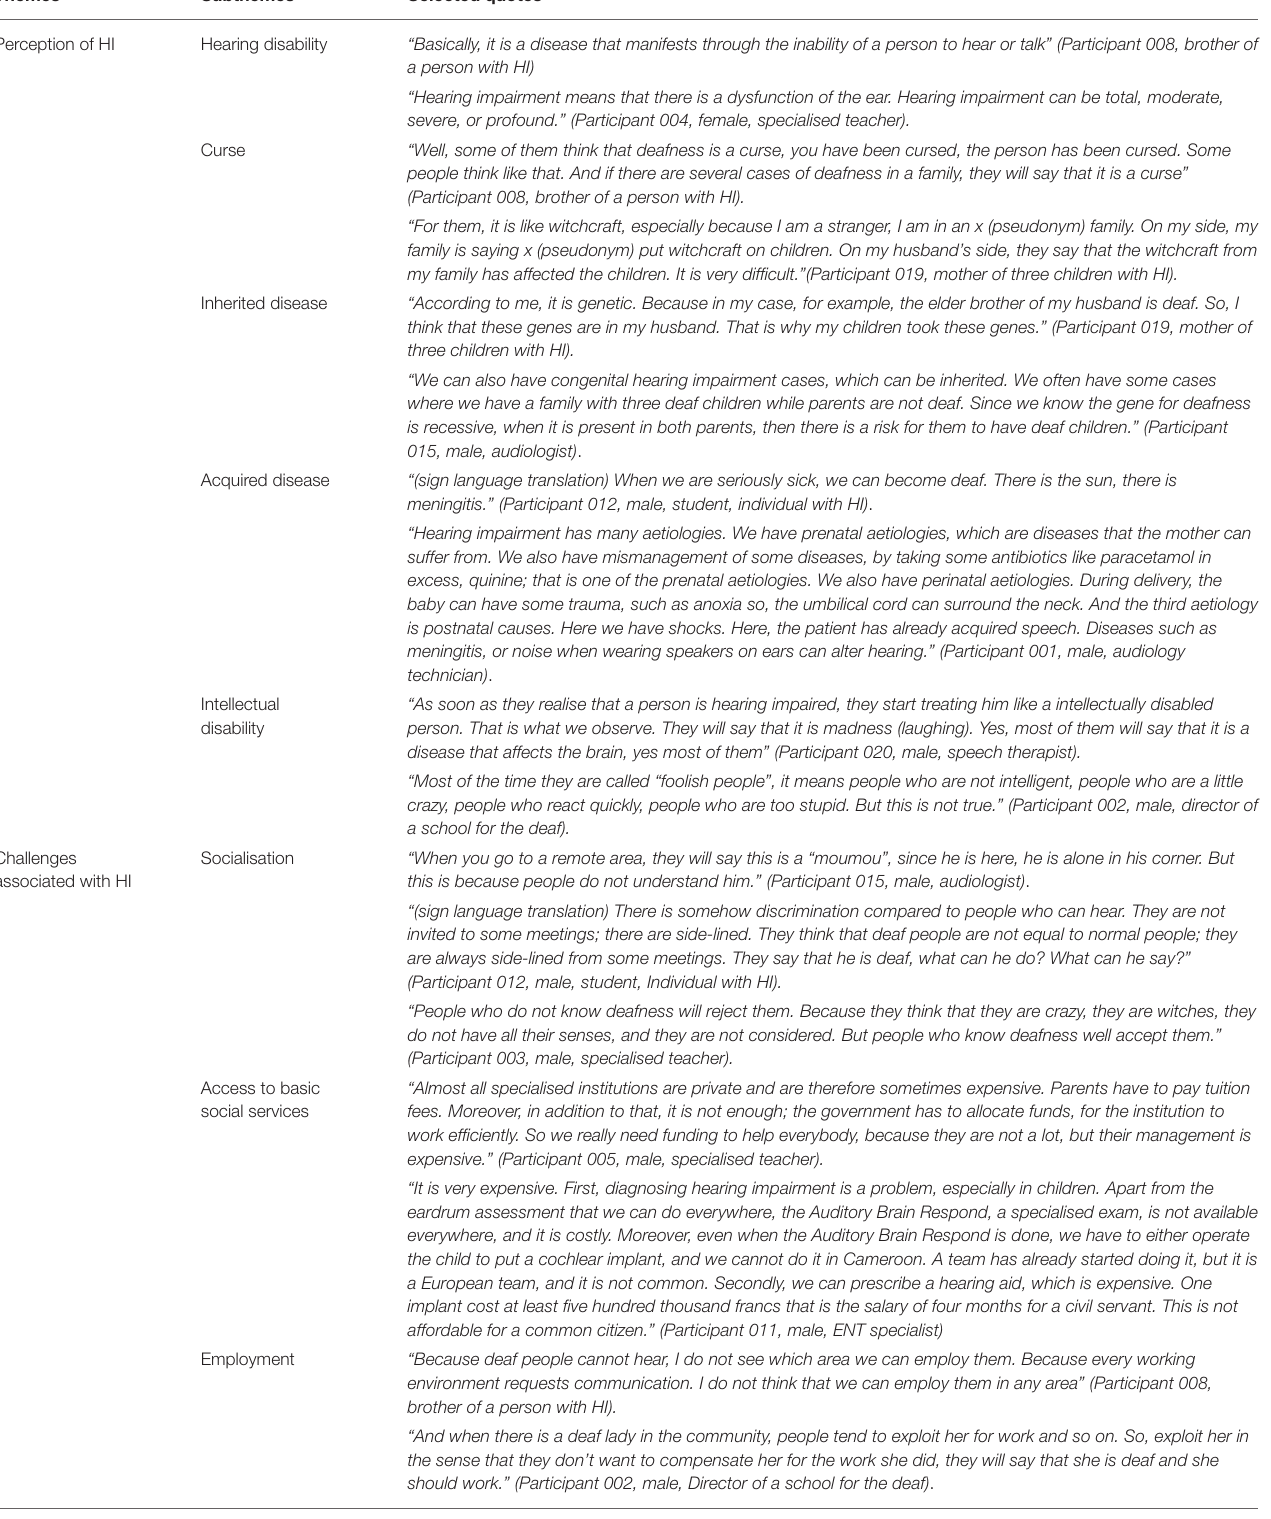
TABLE 2 | Summary of themes and subthemes with selected